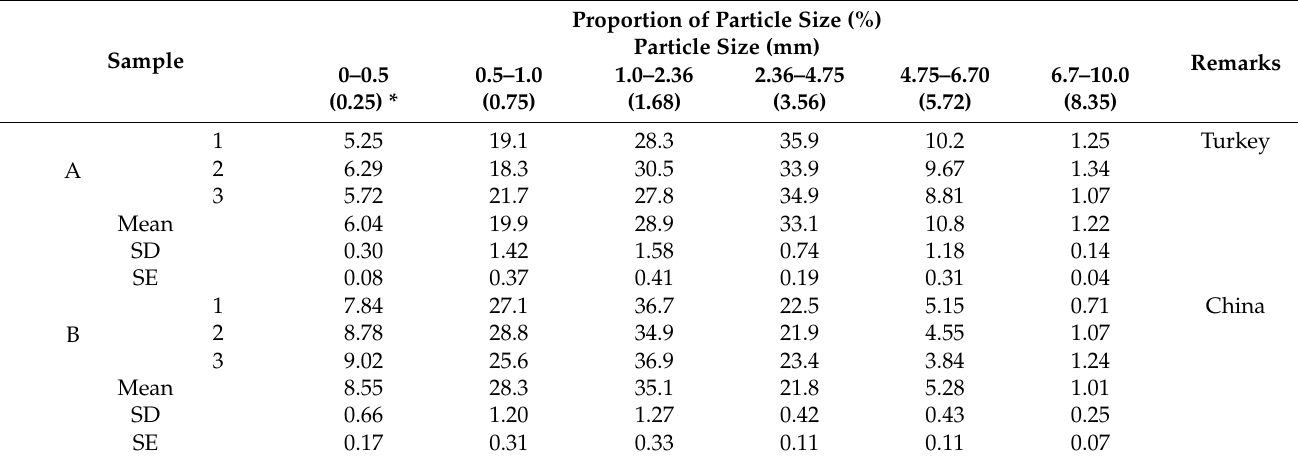
Table 1. Proportion of particle size classified into six different ranges for two EPs of A and B produced from two different crushed raw perlite